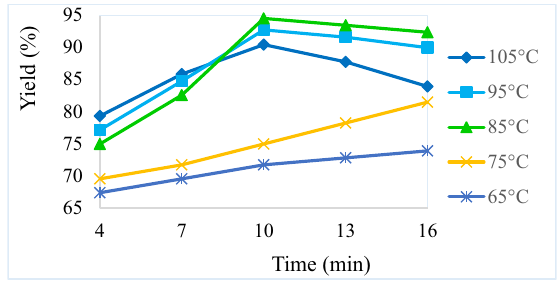
Figure 5: E ff ect of temperature on the CES yield in surveying time of 4 – 16